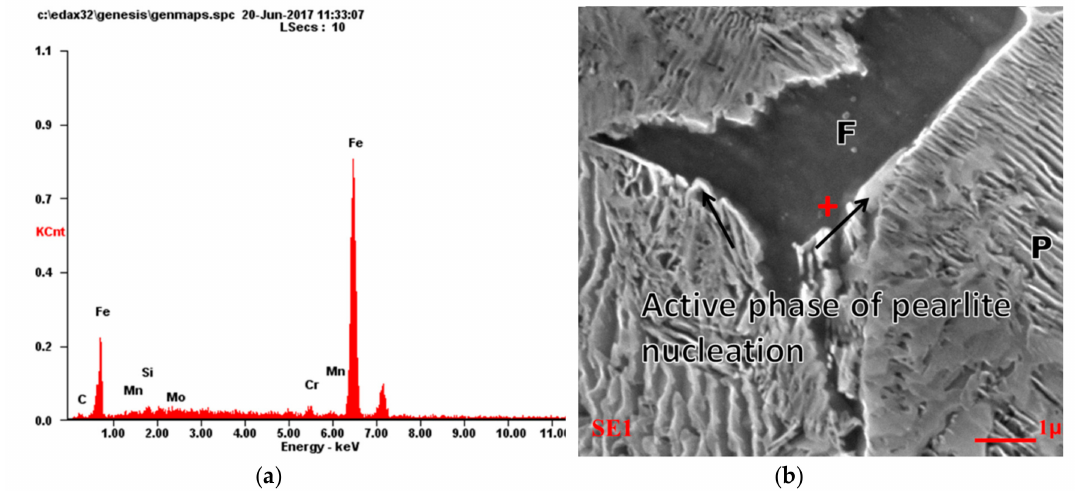
Figure 9. Pearlite nucleation site at the austenite grain boundary at 1 ◦ C / s cooling rate. P: Pearlite, F: Pro-eutectoid ferrite. ( a ) EDS spectrum of elemental quantitative data; ( b ) FESEM micrograph showing pro-eutectoid